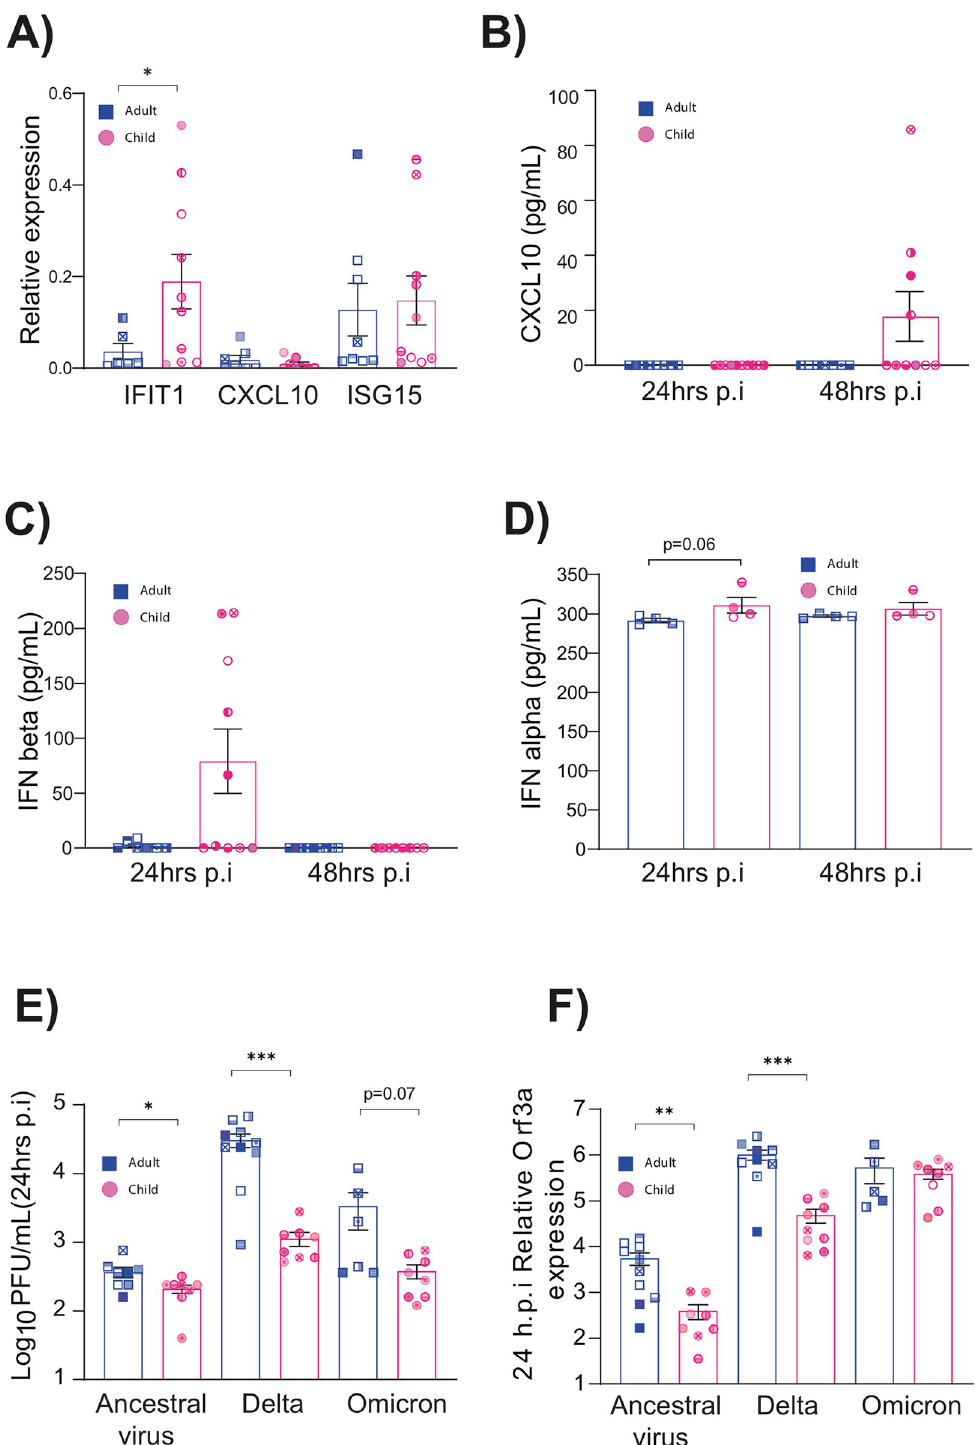
Fig 4. Pediatric epithelial cells have a stronger type I IFN response to viral infection. ( A ) Expression of interferon associated genes in ancestral SARS-CoV-2 (QLD02)-infected epithelial cells relative to uninfected controls (48 h.p.i). Each data point represents a different donor ( N = 8 adults: 5 females, 3 males and N = 10 pediatric: 5 females, 5 males). Gene expression (fold change) was calculated using the ΔΔ Ct method relative to GAPDH expression. ( B–D ) Levels of IFN-alpha, IFN-beta, and CXCL10 in epithelial cell supernatant at 24 and 48 h.p.i with ancestral SARS-CoV-2 (QLD02). Mean ± SEM